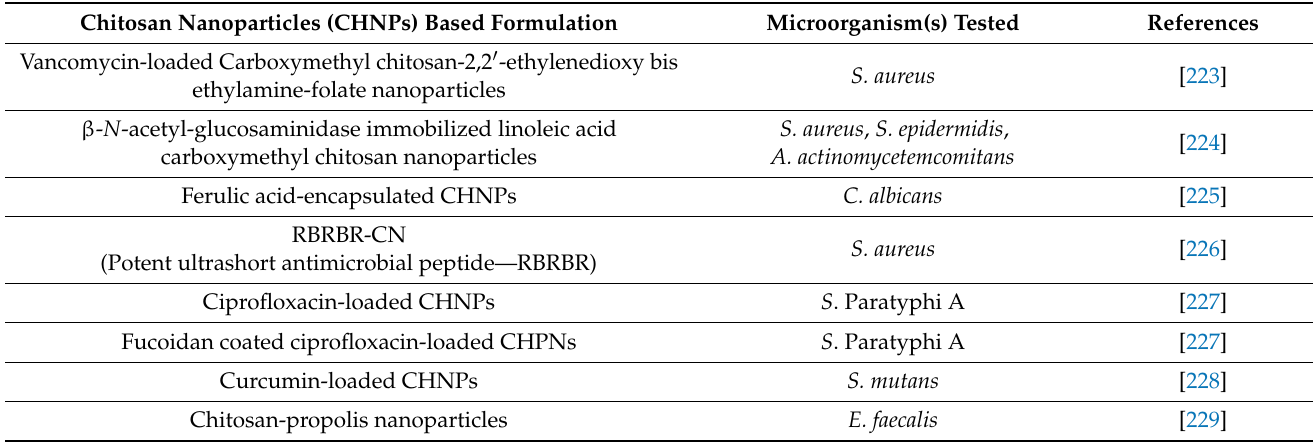
Table 3. Antibiofilm activities of compounds entrapped/immobilized in/on chitosan nanoparticles (CHNPs). Chitosan Nanoparticles (CHNPs) Based